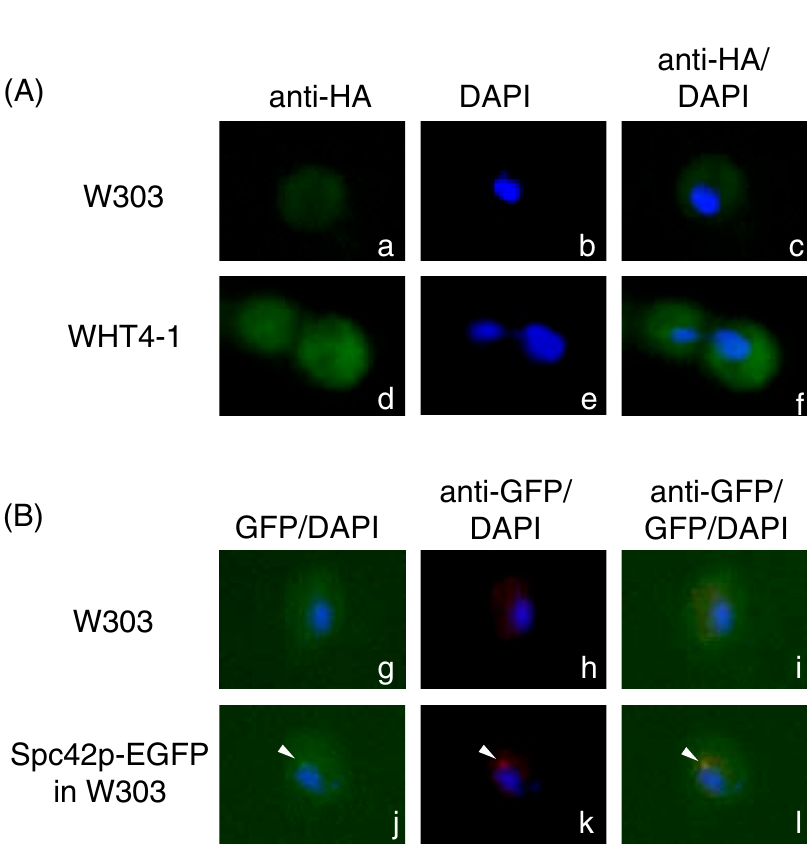
Figure 5 Localization of HA-Ppt1p in yeast cells during early log phase growth . (A) Yeast cells expressing wild-type Ppt1p (W303; a, b, c) or HA-Ppt1p (WHT4-1; d, e, f) were subjected to immunocytochemistry using modified ABC amplification. DAPI was used for nuclear staining. The exposure time for the HA-Ppt1p (green) signal was 5 sec. (B) A spindle pole body pro- tein, Spc42p fused with EGFP (Spc42p-EGFP) was expressed in W303 cells, and localized by both direct green fluorescence of EGFP (j) and indirect red immunofluorescence (k) using the same method of amplification. The exposure times for the direct EGFP signal and the indirect immunofluorescence signal were 5 sec and 40 msec, respectively. Wild-type cells (W303) were used as negative controls for both experiments (a, b, c, and g, h, i). All samples were observed with 1000 ×